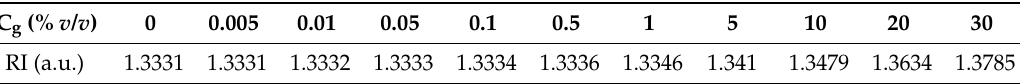
Table 1. The refractive indices measured for various glycerol concentrations (C g ).